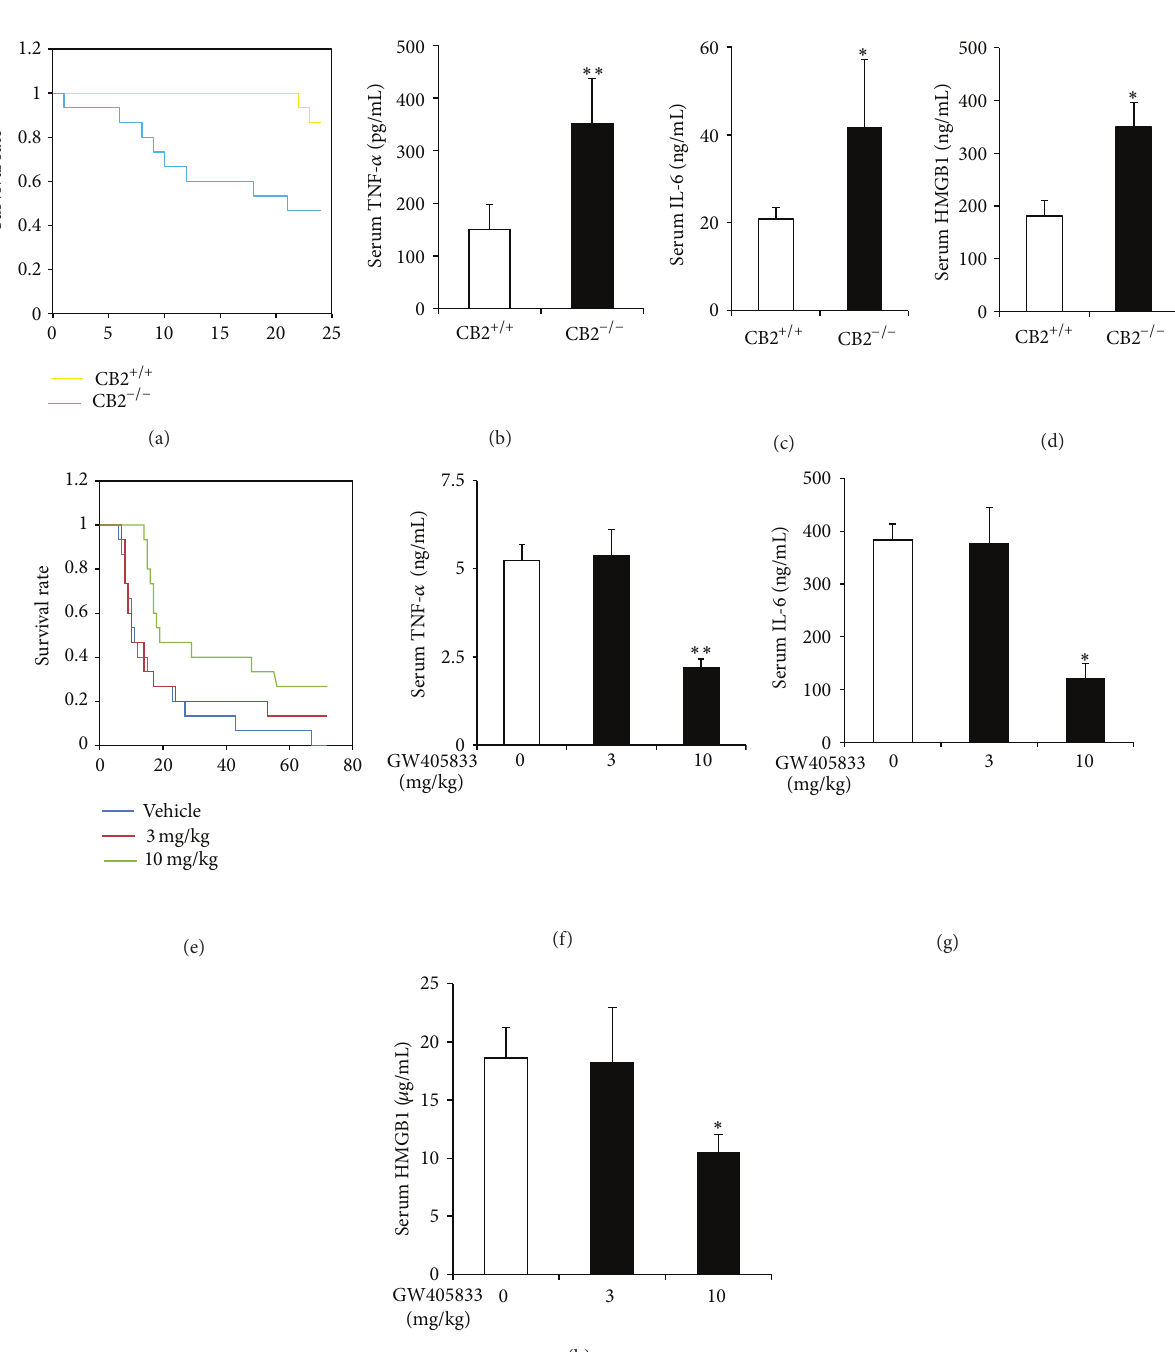
( 𝑛 = 15 ) mice were challenged with LPS (15mg/kg, i.p.). Survival was assessed for 24 h. ∗∗ 𝑃 < 0.01 . (b)–(d), ELISA detection of serum TNF- 𝛼 , IL-6 and HMGB1 levels 3h after LPS (5mg/kg) challenge in CB2 +/+ ( 𝑛 = 5 ) or CB2 −/− ( 𝑛 = 5 ) mice. Data are means ± SEM ∗ 𝑃 < 0.05 , and ∗∗ 𝑃 < 0.01 . (e) Observation of 72 h survival rate in C57BL/6 mice treated with LPS (30mg/kg, i.p.) in the absence of presence of indicated doses of GW405833 (i.p.). Mice treated with vehicle as control. 𝑛 = 15 per group and ∗ 𝑃 < 0.05 versus vehicle. (f)–(h) ELISA detection of serum TNF- 𝛼 , IL-6, and HMGB1 levels 6h after LPS (5mg/kg, i.p.) challenge in the absence or presence of indicated doses of GW405833 (i.p.). 𝑛 = 8 in vehicle, 𝑛 = 5 in 3mg/kg, 𝑛 = 10 in 10mg/kg, data are means ± SEM, and ∗∗ 𝑃 < 0.01 versus